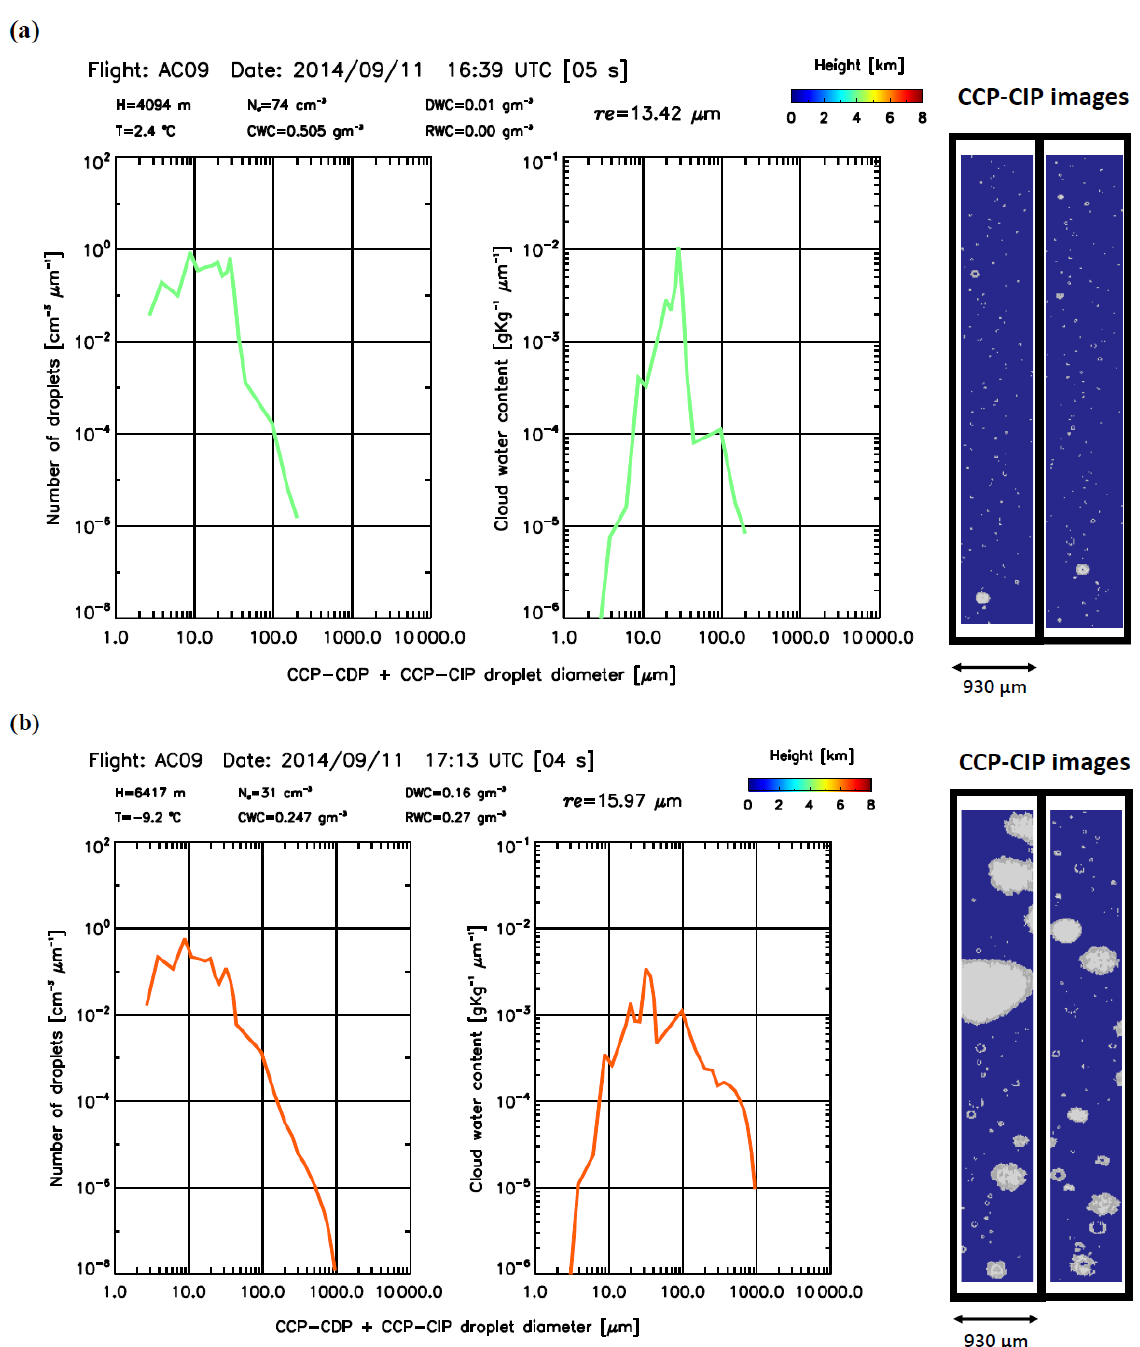
Figure 12. (a, b) Similar to Fig. 5a–c for flight AC09.